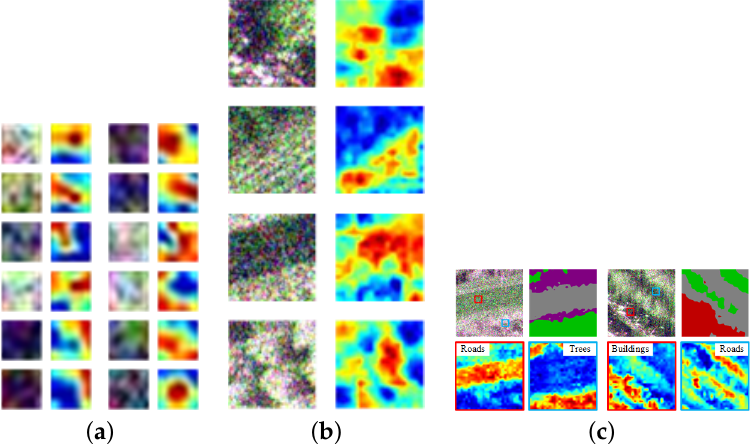
Figure 13. The visualization of the activation maps. ( a ) The 8 × 8 input images ( left ) and activation maps ( right ) of the corresponding category of CNN. ( b ) The 64 × 64 input images ( left ) and activation maps ( right ) of the corresponding category of CNN-Dilated. ( c ) The 224 × 224 input images ( upper left ), the corresponding classification map ( upper right ), and the activation maps ( bottom ) when the model output is an average of the classification results in the red/blue